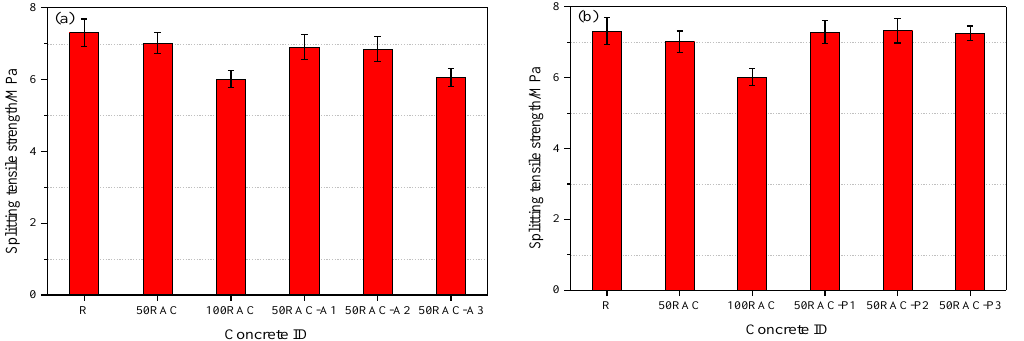
Figure 7. Splitting tensile strength of concrete after 28 days of curing: ( a ) reference concrete and RAC modified with AGA and ( b ) reference concrete and RAC modified with PP.